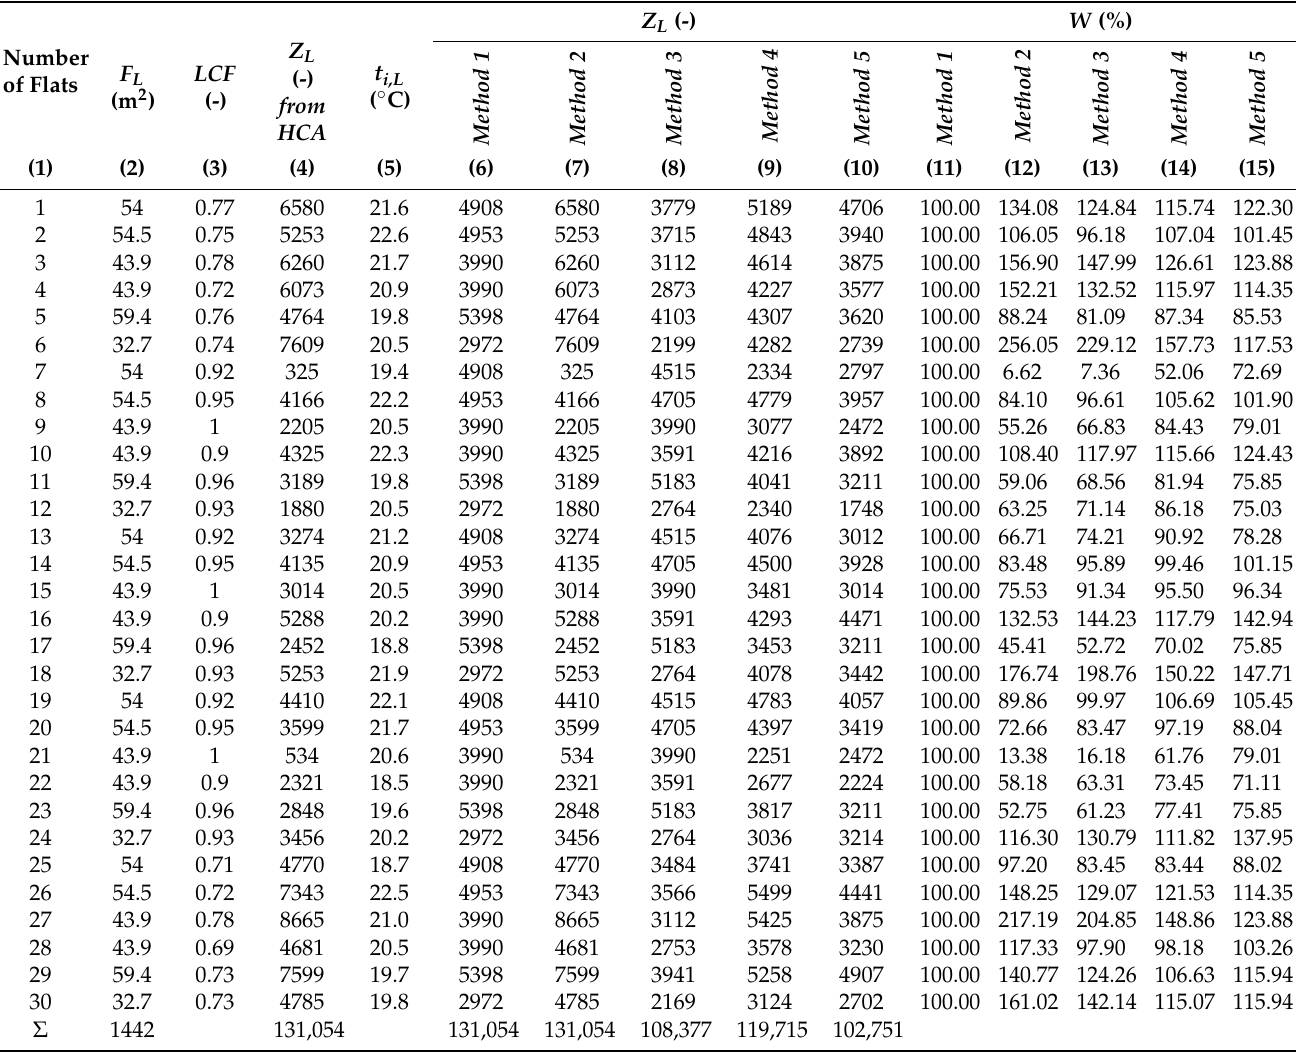
Table 4. Comparison of methods ( method 1–5 ) for variable heat costs allocation taking into account the LCF coefficient on the example of the analysed multi-family